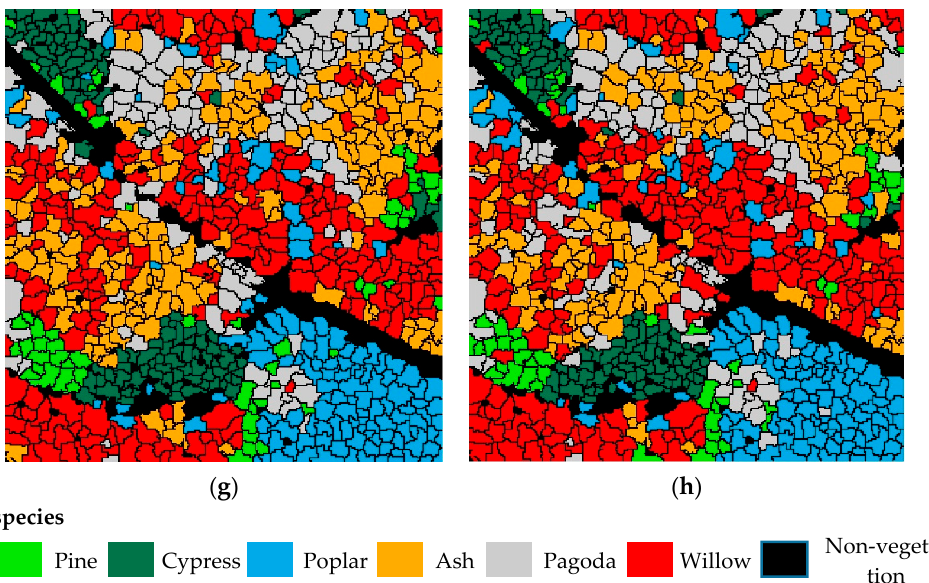
Figure 8. ( a ) The test image. Individual tree species map obtained by ( b ) RF, ( c ) SVM, ( d ) AlexNet, ( e ) GoogLeNet, ( f ) ResNet-18, ( g ) ResNet-34, and ( h ) ResNet-50.